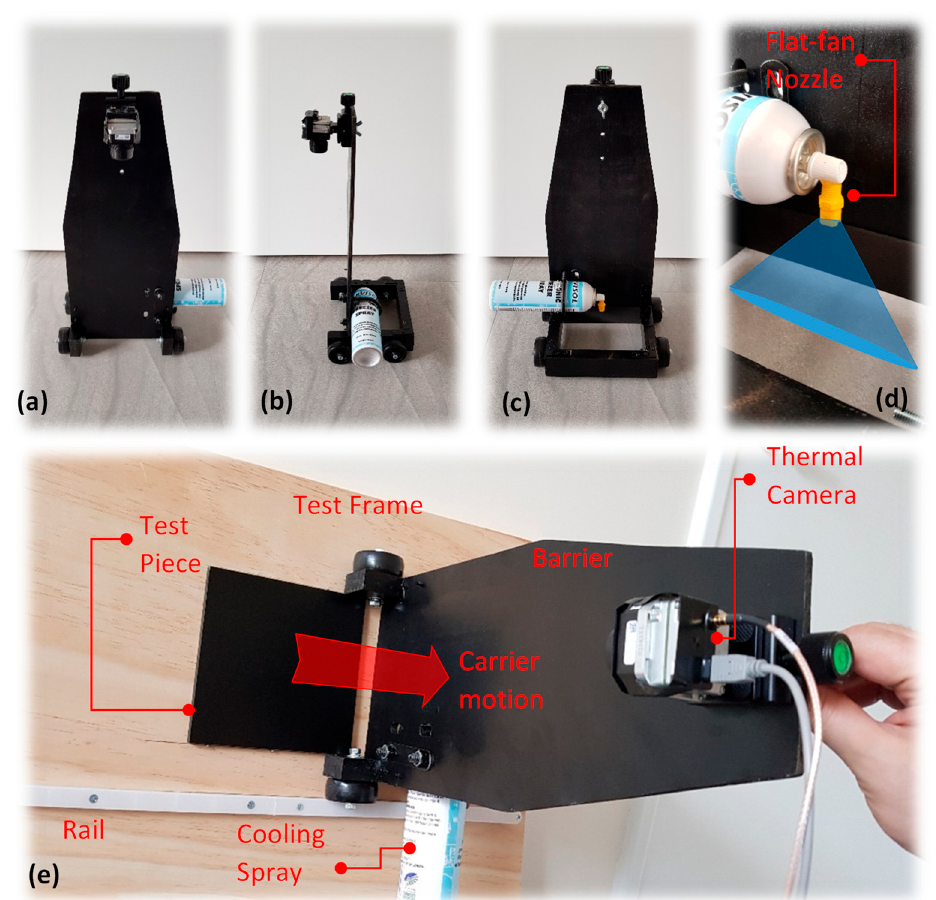
Figure 3. ( a ) Carrier front view; ( b ) carrier side view; ( c ) carrier back view; ( d ) cooling medium spray with customised flat-fan nozzle; ( e ) experimental setup showing carrier motion over the test piece.